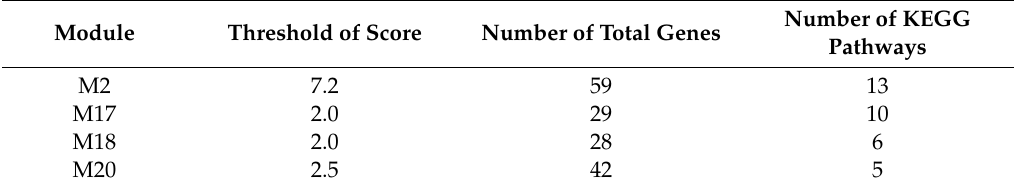
Table 3. KEGG pathway enrichment of conserved first-order genes of modules in the breast TSPPI network.